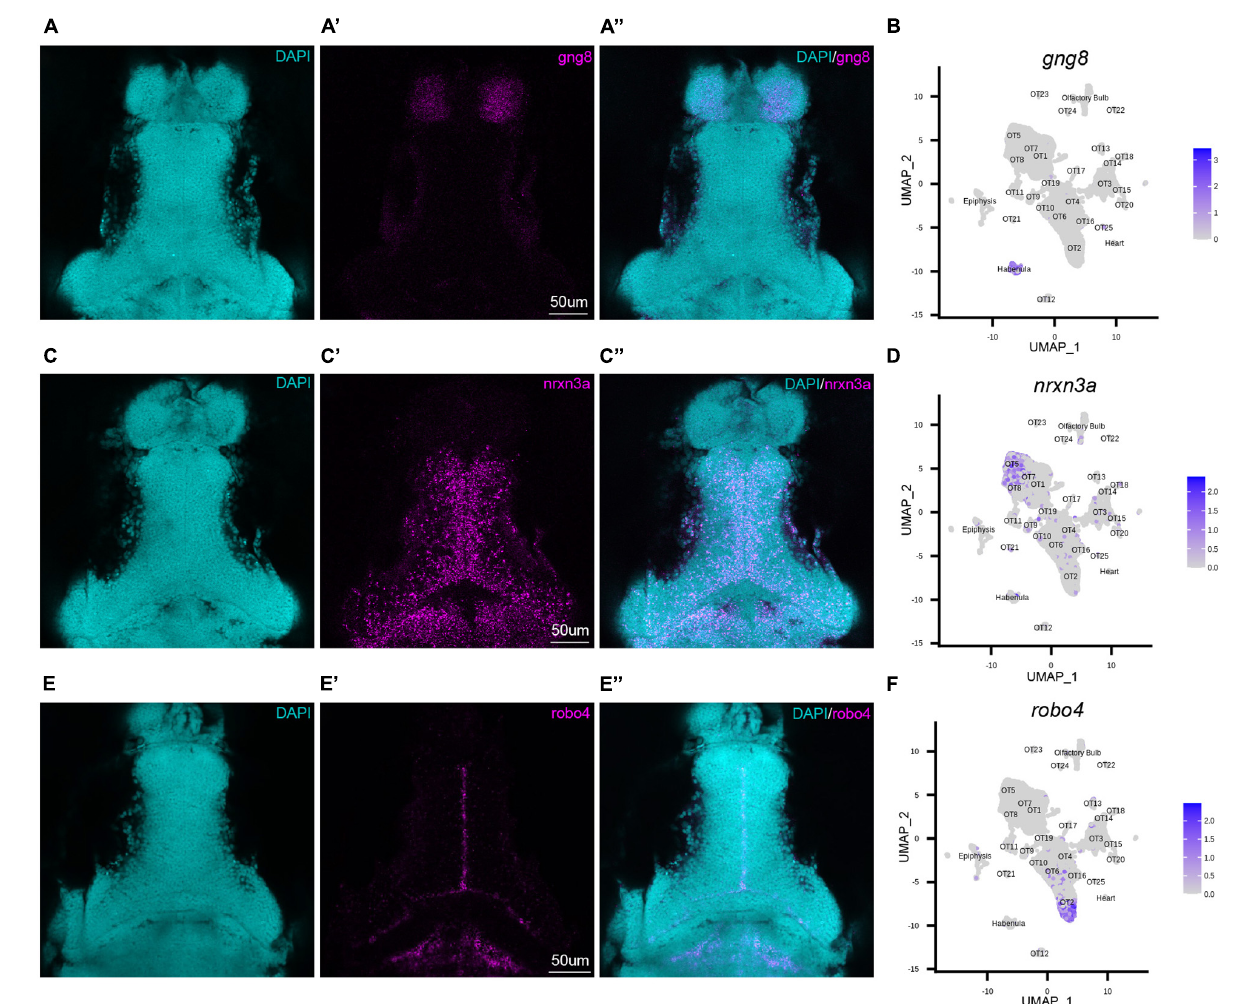
FIGURE 2 | HCR RNA-FISH validates bioinformatic findings and spatially locates tectal populations. Hybridization chain reaction RNA-fluorescence in situ hybridization (HCR RNA-FISH) was performed using proprietary custom probe sets designed by Molecular Instruments to spatially map populations and validate bioinformatic exclusion of non-interest cells. (A–A”,C–C”,E–E”) Single z-slices of representative images showing expression of habenula ( gng8 ) and OT ( nrxn3a , robo4 ) markers in 7 dpf larval zebrafish. (A–A”) gng8 + cells are located in the habenula, validating gng8 expression as a method for annotating habenular cells and spatially mapping 89% of habenula cells ( Supplementary Table 2 ). (B) Feature plot showing gng8 expression is restricted to the annotated habenula cluster. (C–C”) nrxn3a + cells are primarily located medially within the periventricular layer, and spatially map 54% of OT5 ( Supplementary Table 2 ). (D) Feature plot showing expression of nrxn3a is enriched in OT5 and to a lesser extent, OT8. (E–E”) robo4 + OT cells are located near the intratectal commissure, likely within the tectal proliferation zone, and spatially map 51% of OT2 cells ( Supplementary Table 2 ). (F) Feature plot showing robo4 expression is restricted to OT2. All HCR RNA-FISH panels include DAPI staining as a cellular